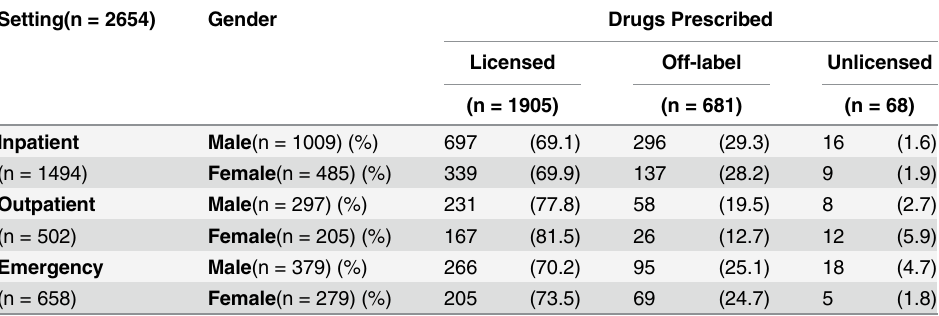
(inpatient); p = 0.0361 (outpatient); p = 0.1182 (Emergency